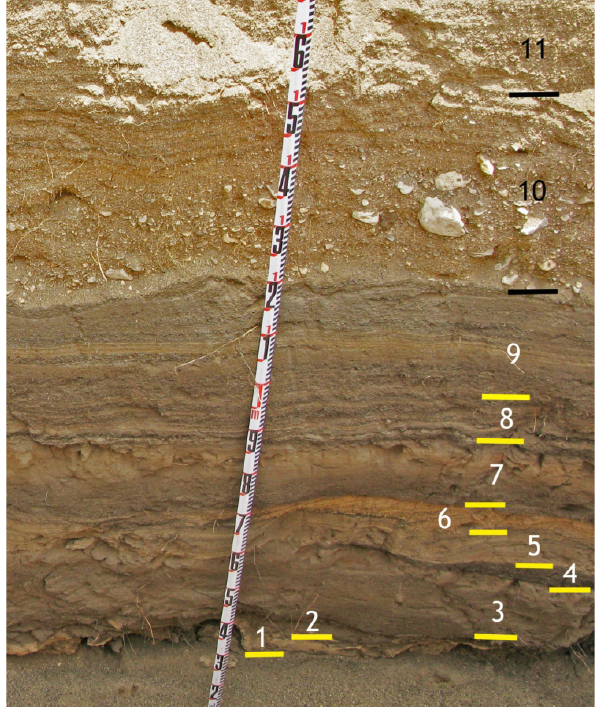
Fig. 9. Partial view of the BG-1 stratigraphic sequence.